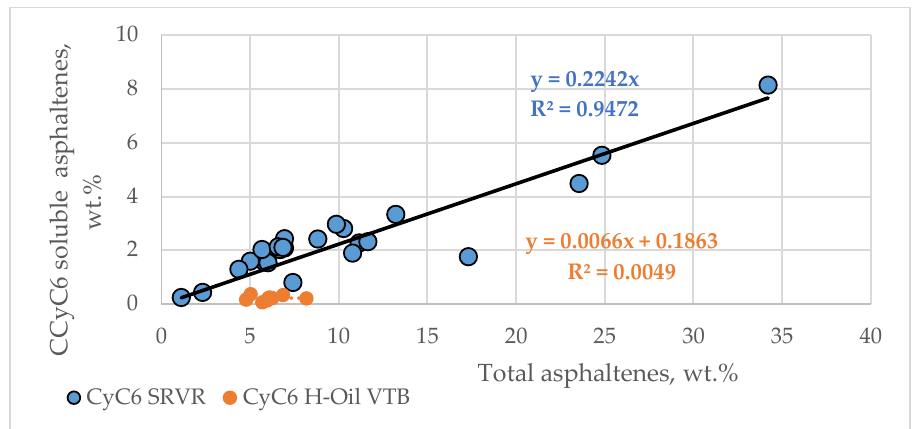
Figure 6. Relation of SAR-AD TM total asphaltene content to cyclohexane-soluble asphaltene content.